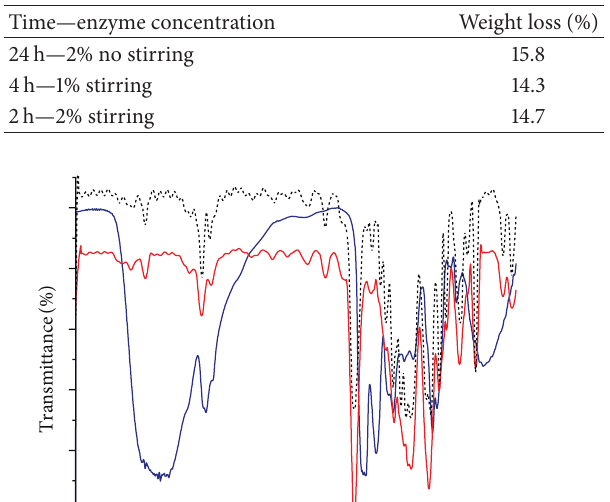
Table 4: Weight loss in PET samples coated with whey and treated with Terg-a-zyme.